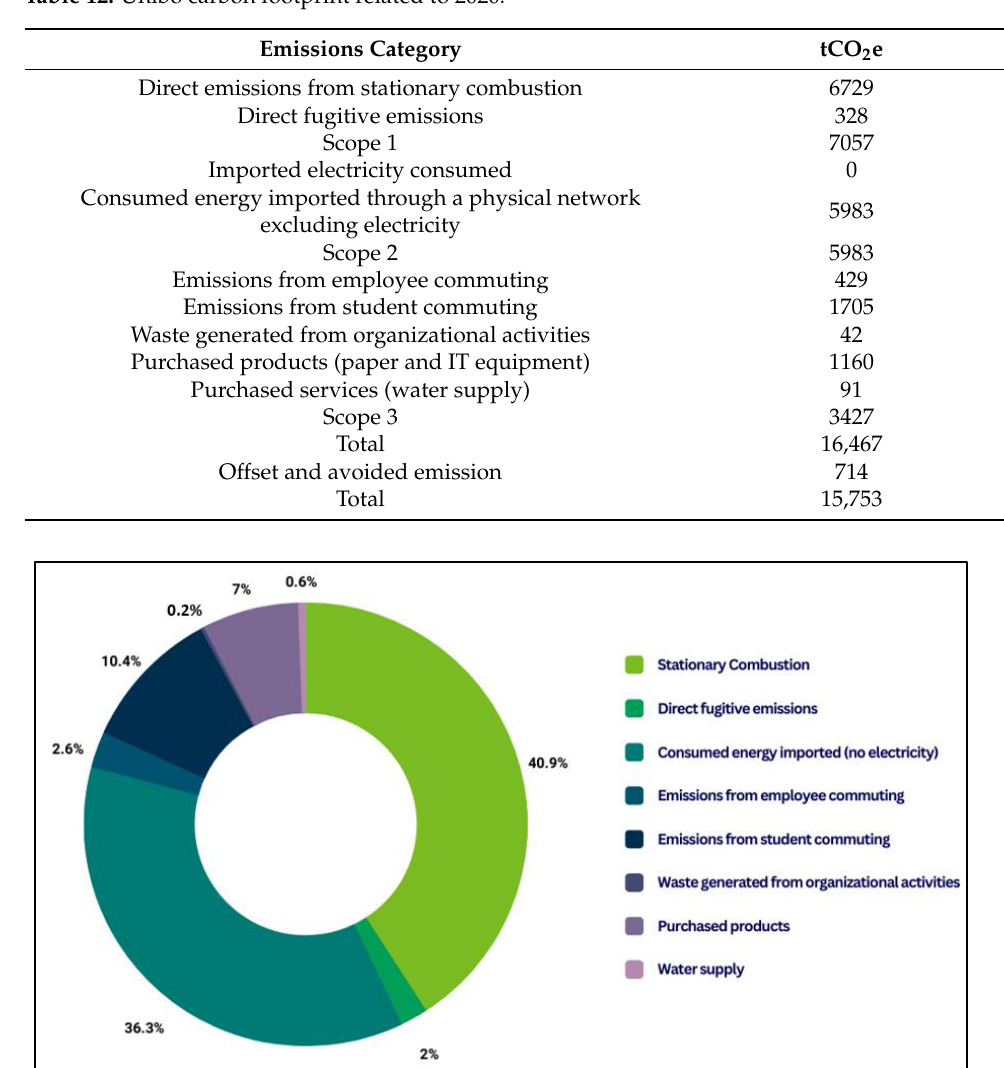
Figure 3. Tons of CO 2 e by emission categories.